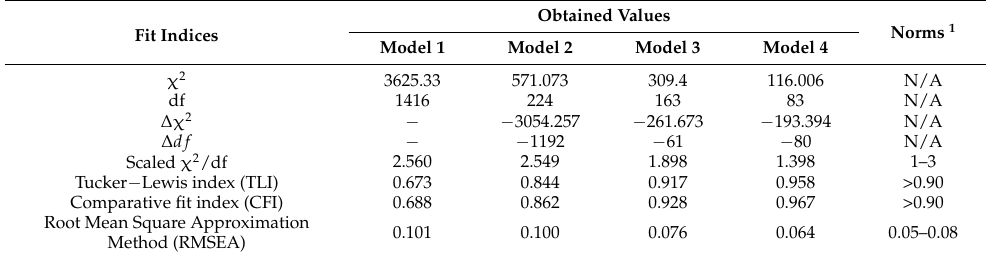
Table 4. Fit indices for the models.